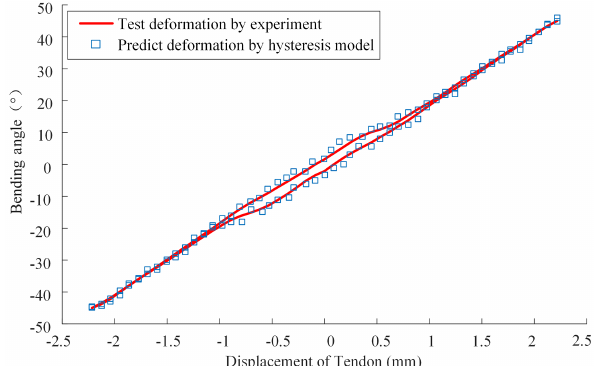
Figure 9. Comparison between actual and theoretical bending an- gle under discrete signals.